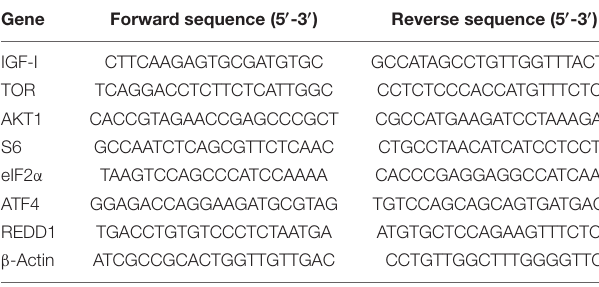
TABLE 4 | Specific primer used in the present